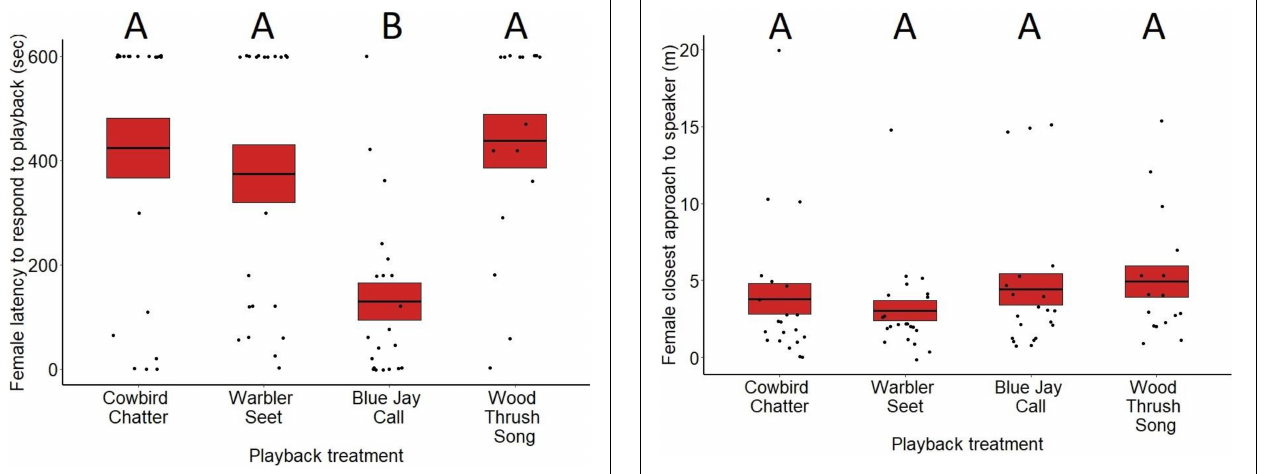
FIGURE 4 | Closest approach to the playback speaker (in meters) by female red-winged blackbirds for the different treatments at nests during nestling stage. Means are shown with the bold line, and shaded boxes represent standard errors. There were no significant pairwise differences; for the p -values of post hoc comparisons, please refer to Supplementary Table 2 .